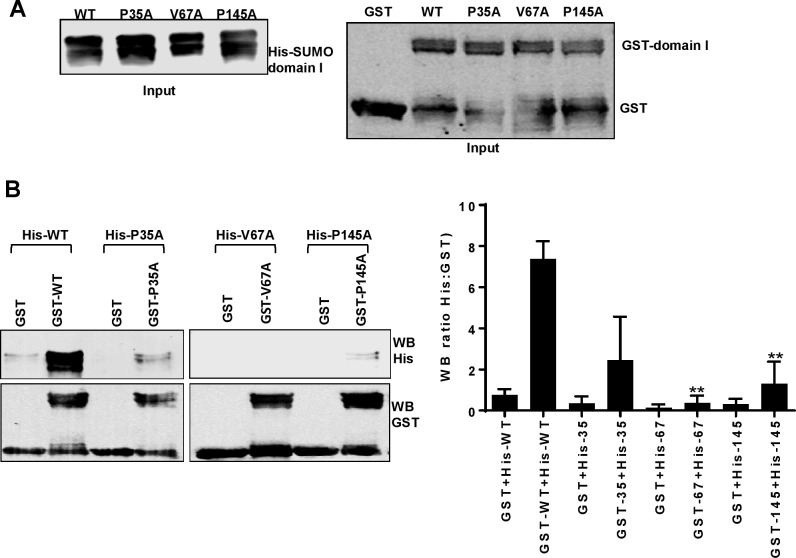
Residues at positions V67 and P145 of domain I are involved in NS5A dimerization.A Input of His-SUMO-domain I (35–215) (left), GST control protein and GST-domain I (35–215) (right), analysed by Western blotting using either anti-His or anti-GST antibodies. B His-tagged domain I proteins were also used as prey in pulldown assays with GST or GST-Domain I with corresponding mutations as bait. Precipitated proteins were analysed by Western blotting using anti-His and anti-GST antibodies. The His:GST ratio was calculated following quantification of Western blot signals using a Li-Cor Odyssey Sa infrared imaging system and represented graphically as a measure of the dimerization activity. These data were representative of three independent experiments using different batches of purified domain I proteins. ** indicates significant difference (P<0.01) from WT.